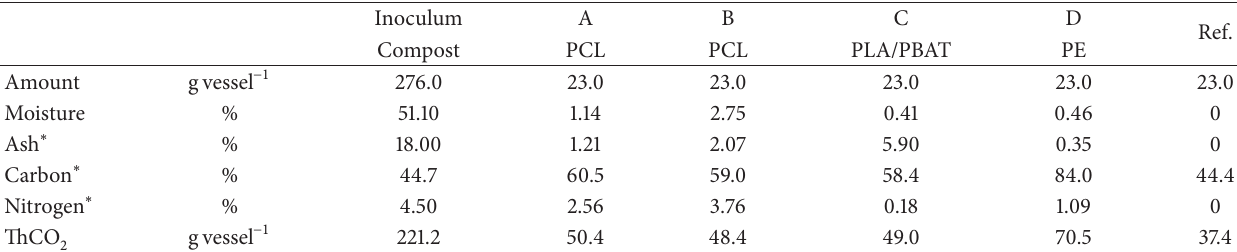
Table 1: Characteristics of the samples used in the trials of the experimental apparatus.